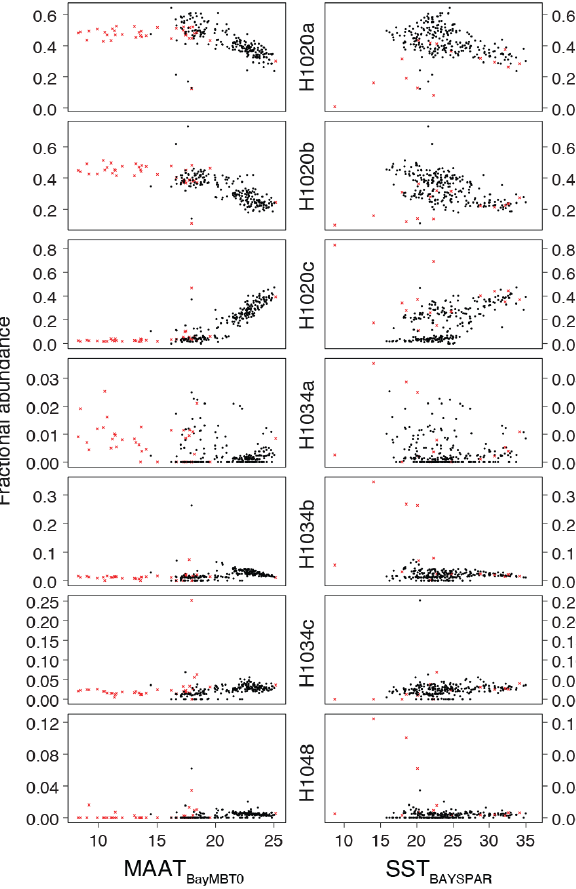
Figure 11. Fractional abundances of brGMGTs plotted against MAAT soil and SST lin . Red crosses are those samples that have non- thermal overprints on the